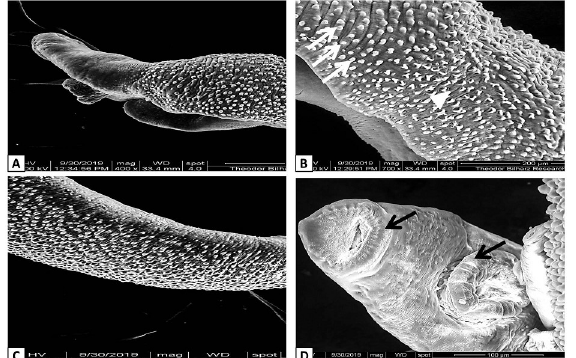
Fig 5. Scanning electron micrograph of dorsal surface of adult male S . mansoni recovered from A and B Infected non-treated mice (G2) showing numerous tubercles bearing directed spines (white arrows) and intertubercular ridges (white arrow head); C and D Prophylaxis group (G3) showing mild distortion of the tubercles bearing short and blunt spines on the dorsal surface with prominent oral and ventral suckers (black arrows).